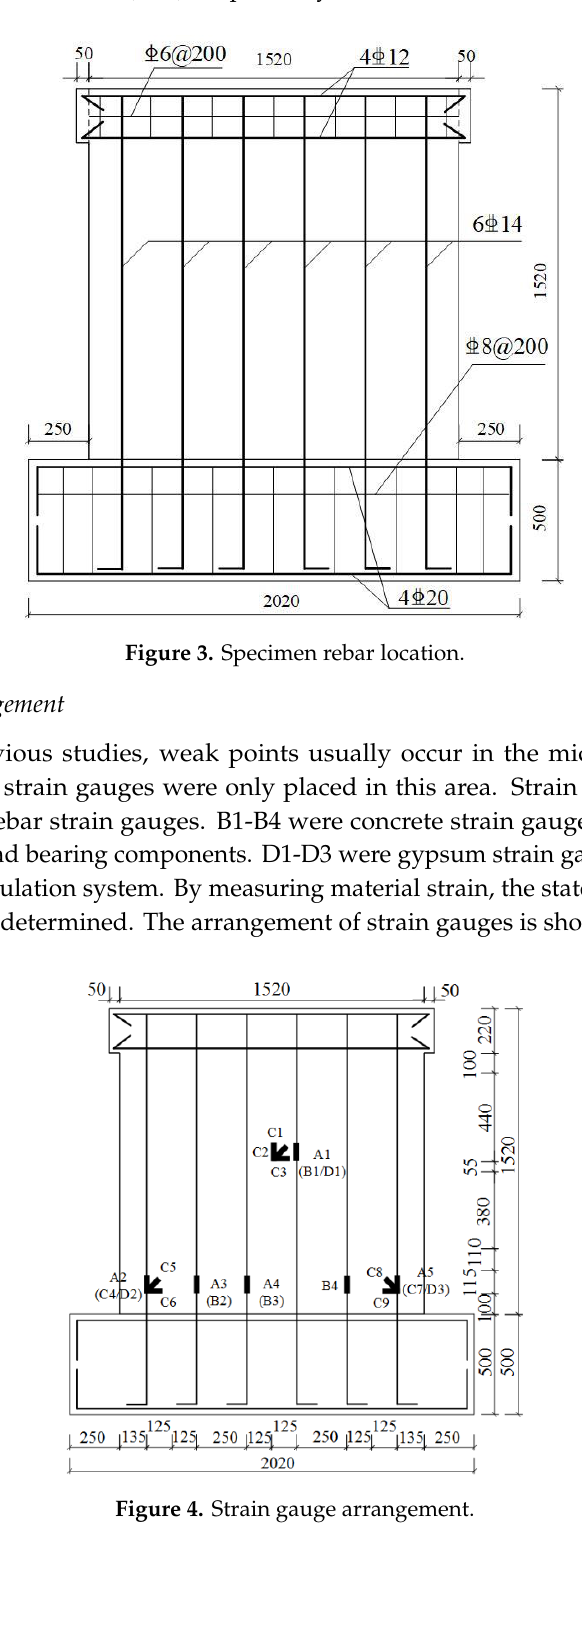
Figure 4. Strain gauge arrangement.